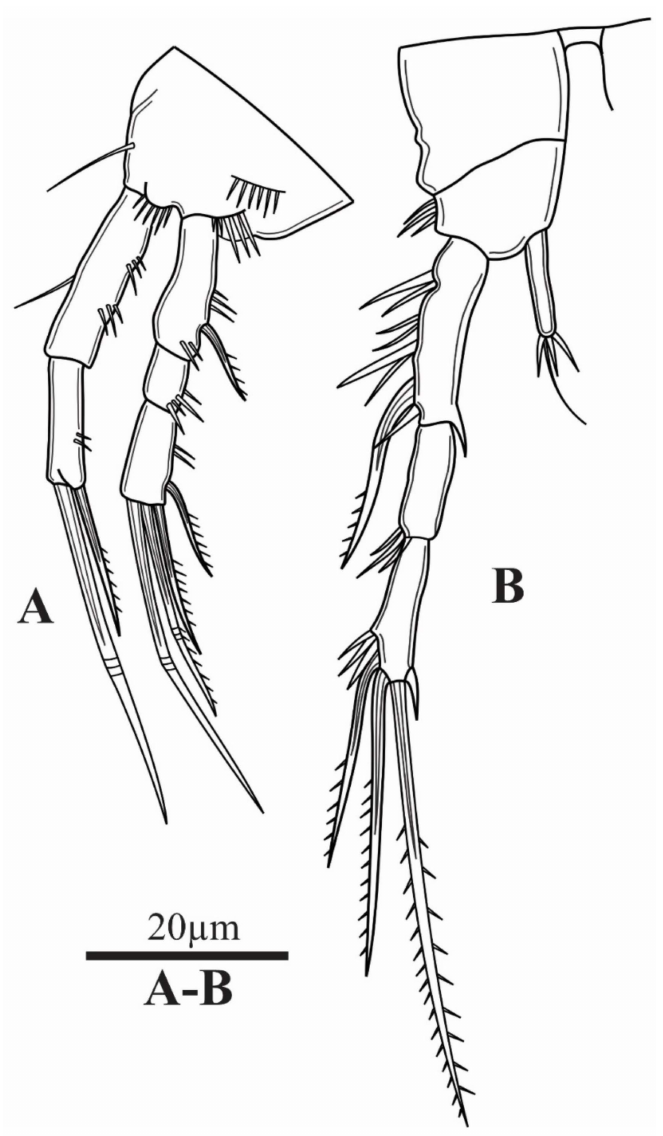
Figure 5. Parastenocaris sontraensis sp. nov. holotype female. ( A ), P1; ( B ), P2. P4 (Figure 6B) coxa trapezoidal. Basis with one thin, short, and smooth outer